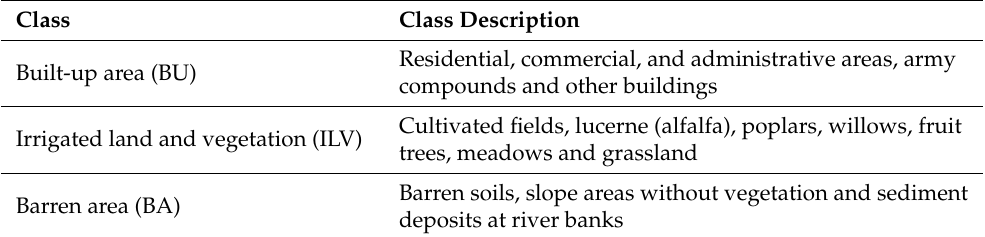
Table 2. Description of land use and land cover class in the study